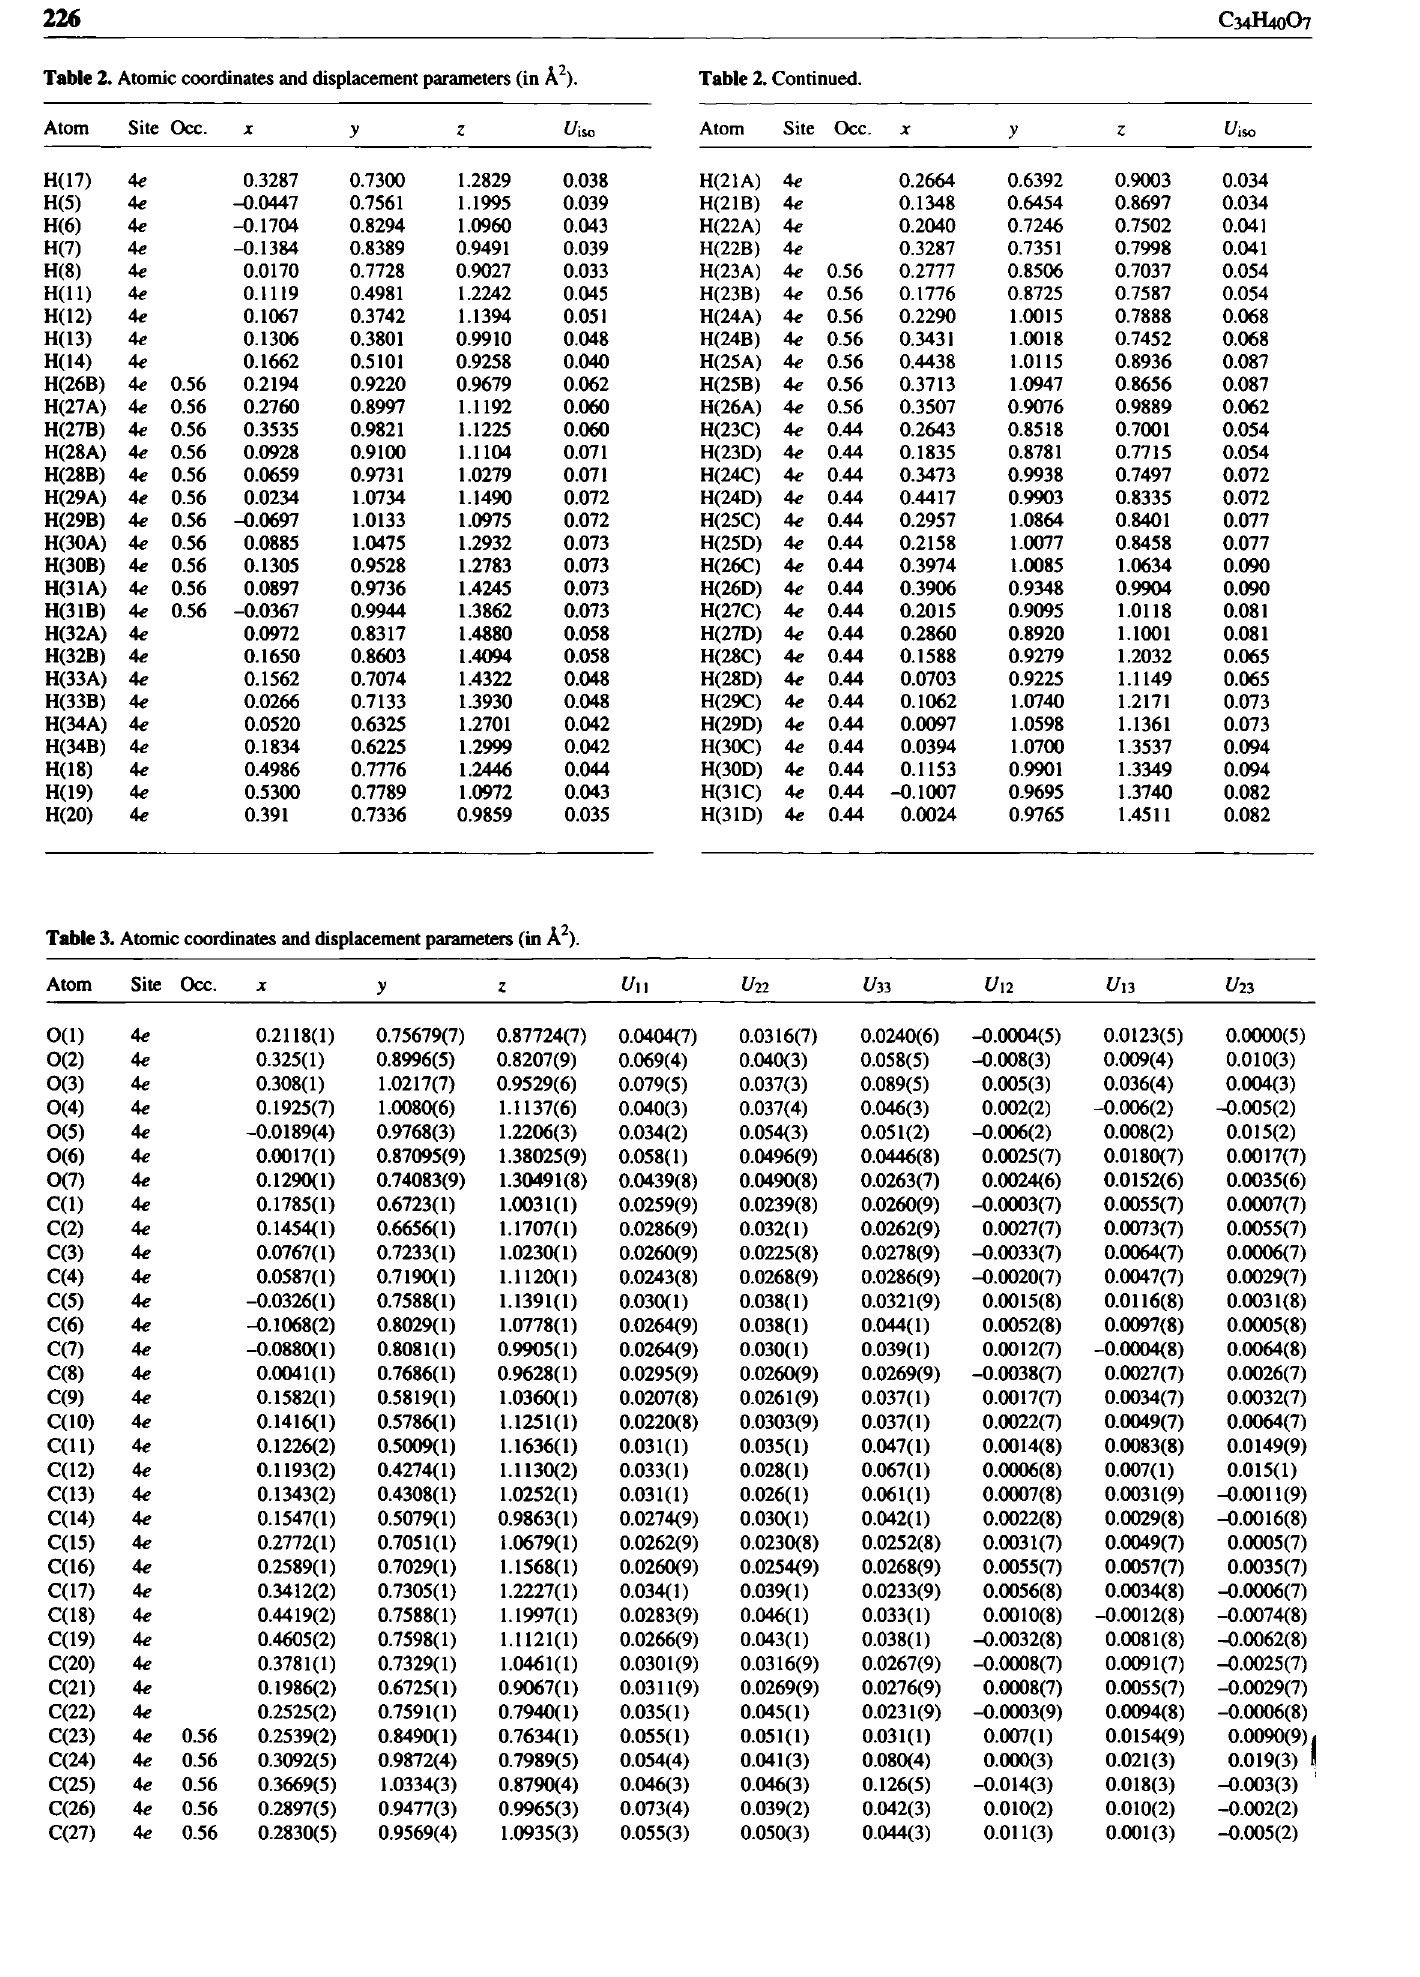
Table 2. Atomic coordinates and displacement parameters (in λ 2 ).